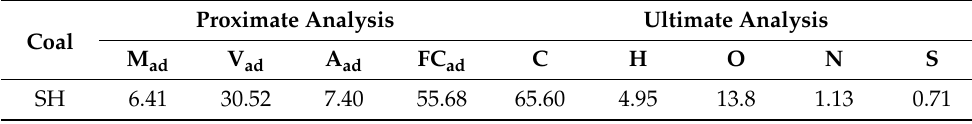
Table 1. Proximate and ultimate analysis of Shenhua (SH).